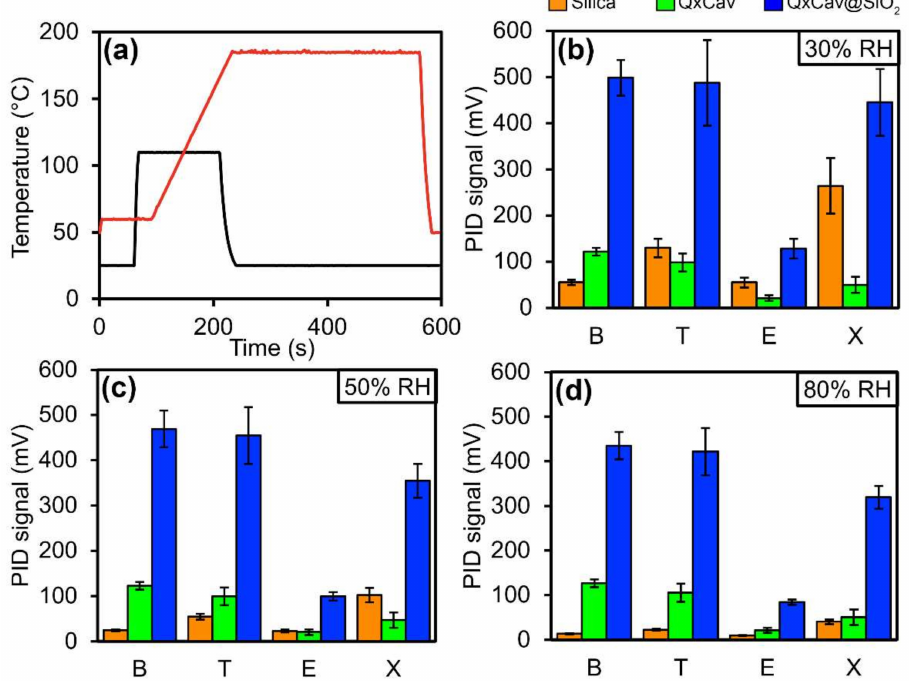
Figure 3. ( a ) Temperature profile of preconcentrator (blue) and gas chromatography column (orange). Histograms of PID signals at 30 ( b ), 50 and ( c ) 80 ( d ) relative humidity (RH) for benzene (B, 3 ppb), toluene (T, 3 ppb), ethylbenzene (E, 3 ppb) and p-xylene (X, 6 ppb) with the three absorption phases. Each value is the average of 20 individual